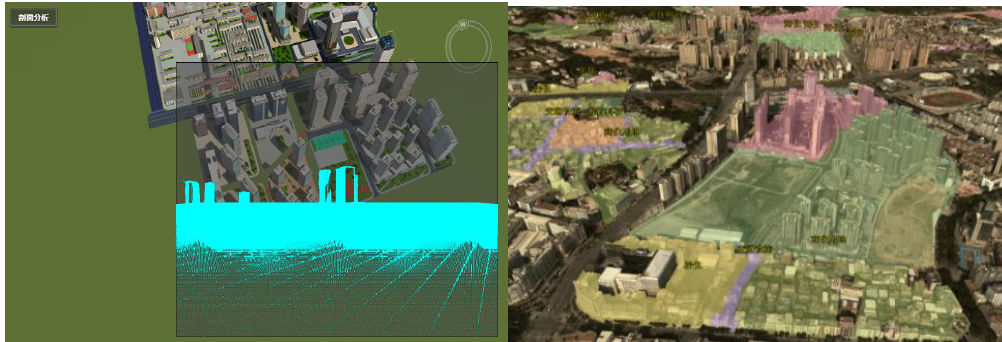
Fig.6 profile drawing and conflict detection